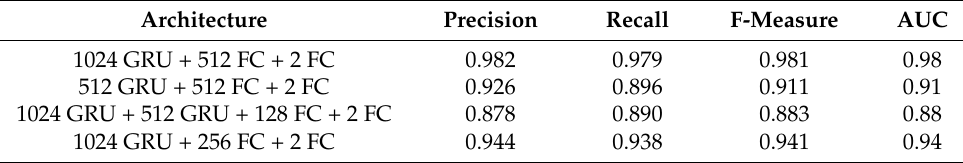
Table 3. Sequence learning architecture performance for zone-based prediction.